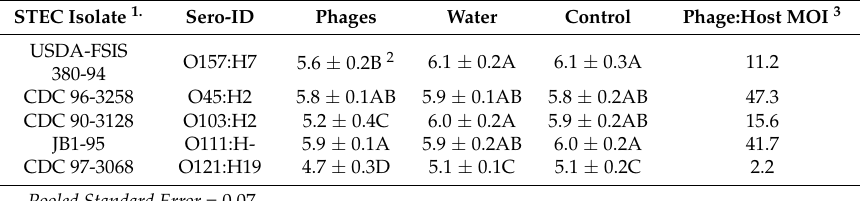
Table 2. Survival of Shiga-toxigenic Escherichia coli (STEC) isolates on beef cattle hide pieces by the application of antimicrobial treatment and the multiplicity of infection of phages: STEC host. STEC Isolate 1. Sero-ID Phages Water Control Phage:Host MOI